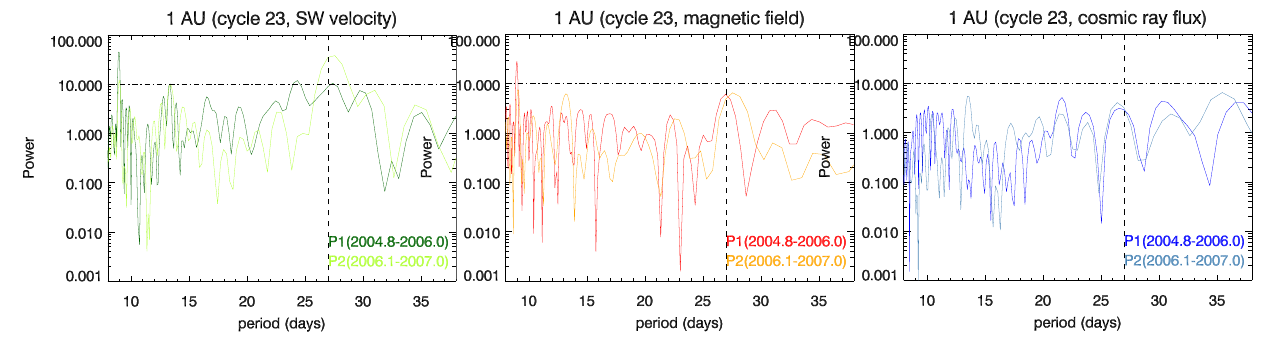
Fig. 10. Lomb periodograms for the solar wind speed (SWEPAM) and magnetic field (MAG), measured on the ACE spacecraft as well as the GCR flux (EPHIN instrument on SOHO), the representation is the same as in Fig. 6, the vertical line shows again 27 days.